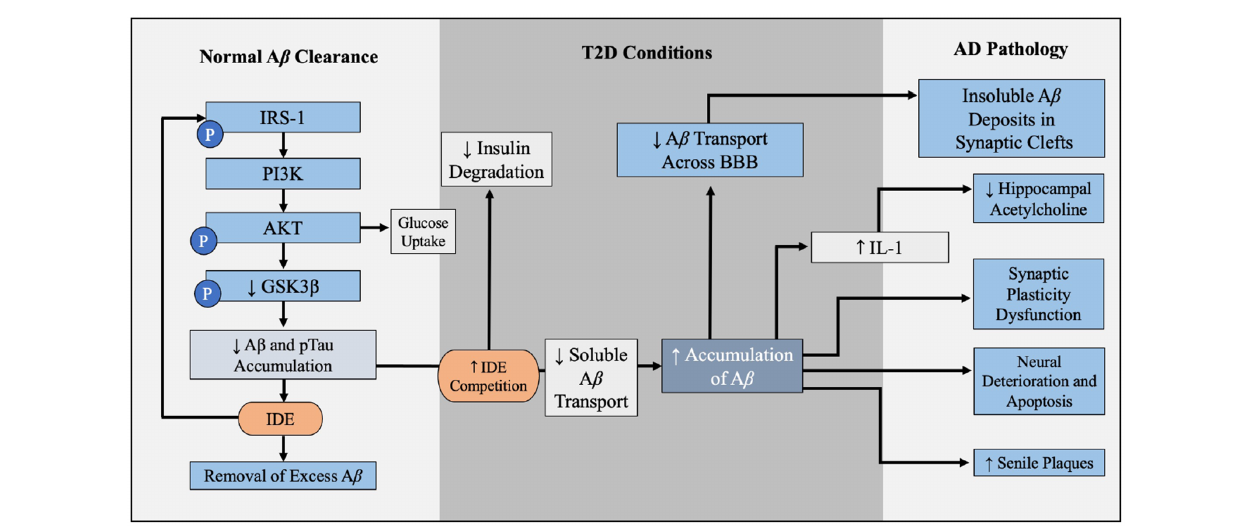
FIGURE 6 | Contribution of T2D conditions to A β accumulation and AD pathology. In the healthy brain insulin signaling pathway, insulin binds to PI3K which is degraded to AKT, leading to GLUT4-mediated glucose uptake and phosphorylation (inactivation) of GSK3 β . GSK3 β inactivation leads to decreased A β and pTau accumulation, and IDE degrades excess insulin and A β in the brain. When IR and hyperinsulinemia is developed during T2D, this increased competition for IDE, leading to A β and insulin accumulation, further illustrated in Figure 4 . Increased A β accumulation leads to increased decreased soluble A β transport across BBB, leaving insoluble A β deposits trapped within the synaptic clefts, promoting inflammation and oxidative stress and increasing NF-kB. Increased levels of NF-kB increases IL-1 expression, which reduces hippocampal acetylcholine. Excess A β decreases synaptic plasticity, promotes neural deterioration and apoptosis, and promotes A β plaques. A β plaques is a well-established contributors to AD. Abbreviations: A β , amyloid beta; T2D, type 2 diabetes; AD, Alzheimer’s disease; PI3K, phosphoinositide 3-kinase; AKT, protein kinase B; GLUT4, glucose transporter 4; GSK3 β , glycogen synthase kinase 3 β ; pTau, hyperphosphorylated tau; IDE, insulin degrading enzyme; IR, insulin resistance; BBB, blood-brain